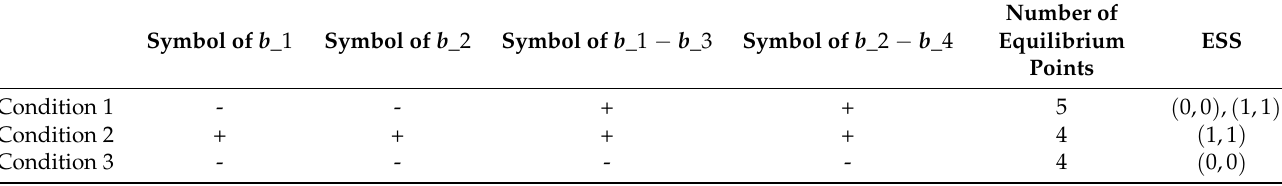
Table 4. Conditions of the system of replication dynamics and equilibrium